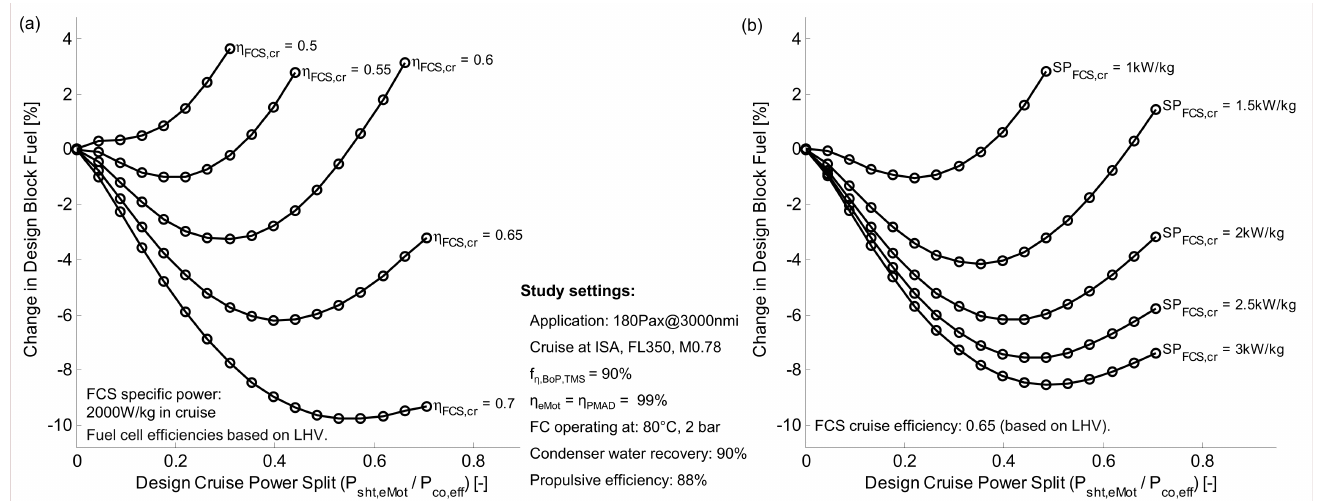
Figure 10. Design block fuel results of initial aircraft-integrated sizing study: ( a ) sensitivity to FC system efficiency, ( b ) sensitivity to FC system specific power.